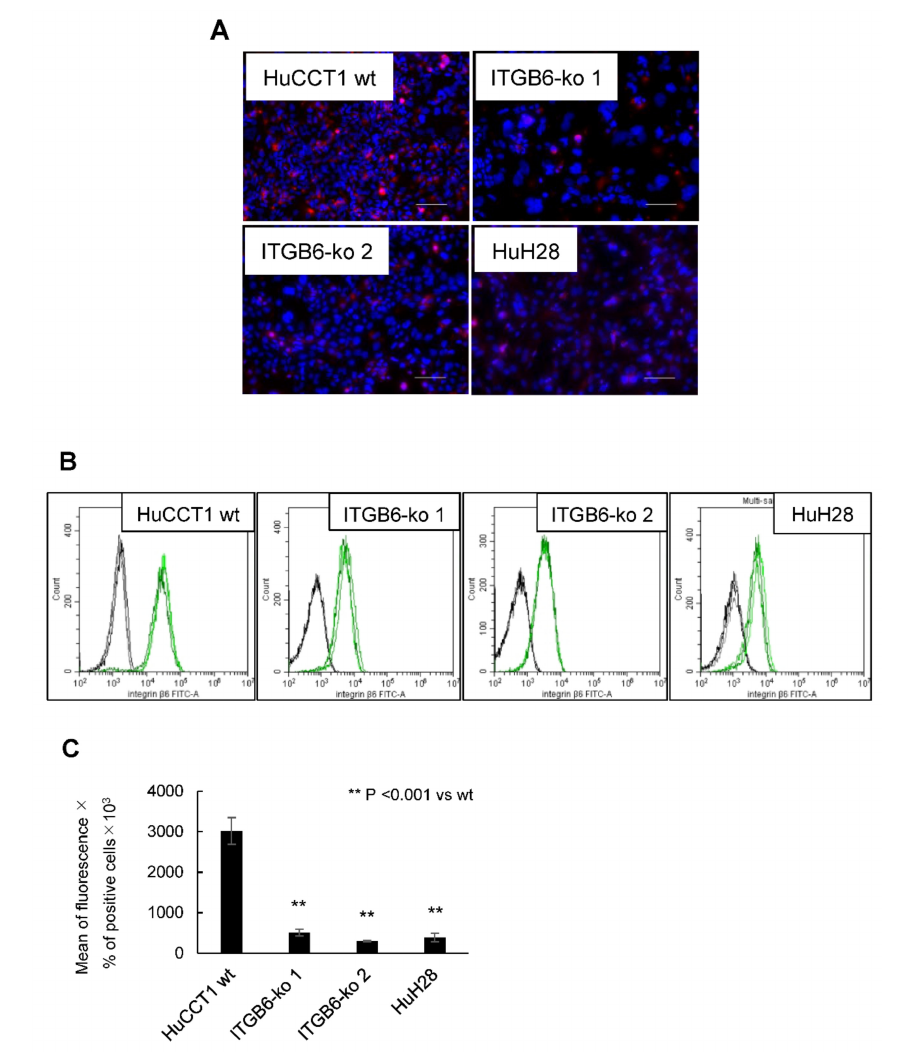
Figure 1. Integrin β 6 protein was reduced in integrin β 6-knockout ( ITGB6 -ko) cell lines by im- munofluorescence staining and flow cytometry. ( A ) Integrin β 6 staining (red) in the cytoplasm and plasma membrane of HuCCT1 wild-type (wt), ITGB6 -ko cells, and HuH28 (scale bar, 100 µ m). ( B ) Representative histograms for integrin β 6 expression determined by flow cytometry (black lines, mouse IgG1; green lines, mouse monoclonal anti-integrin β 6). ( C ) The mean fluorescence intensity was multiplied by the percentage of integrin β 6-positive cells to determine integrin β 6 expression. The expression of integrin β 6 was significantly decreased in ITGB6 -ko 1 and -ko 2 cells compared with HuCCT1-wt cells ( p < 0.001) as well as HuH28 cells as a negative control. Experiments were performed in